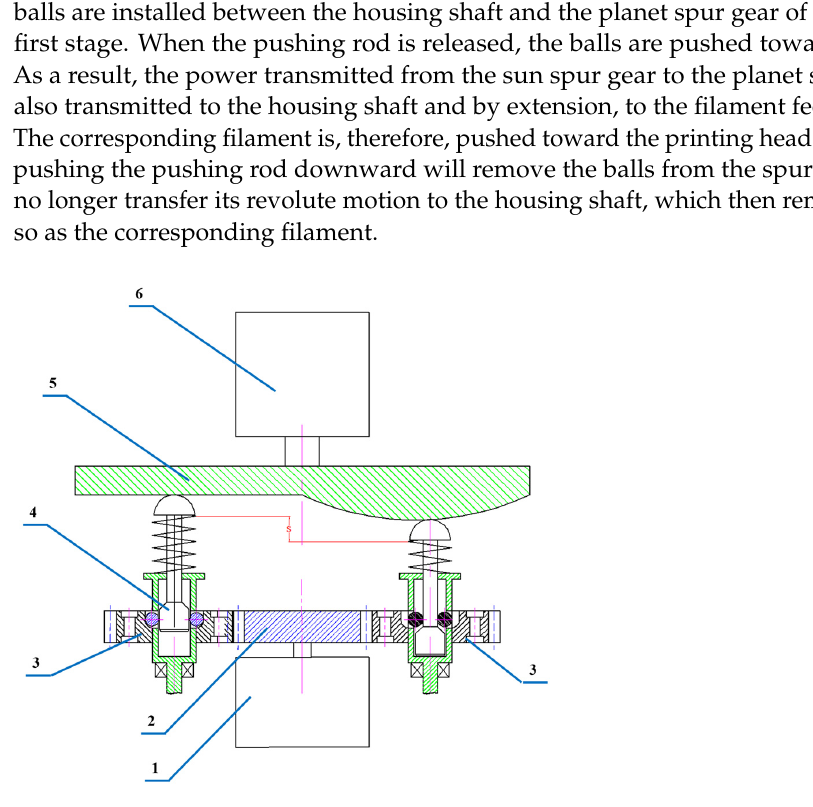
Figure 4. Schematic view of the filament shifting mechanism; 1—Stepper motor; 2—Sun spur gear; 3—Planet spur gear; 4—Pushing rod; 5—Cam disk; 6—Stepper motor.